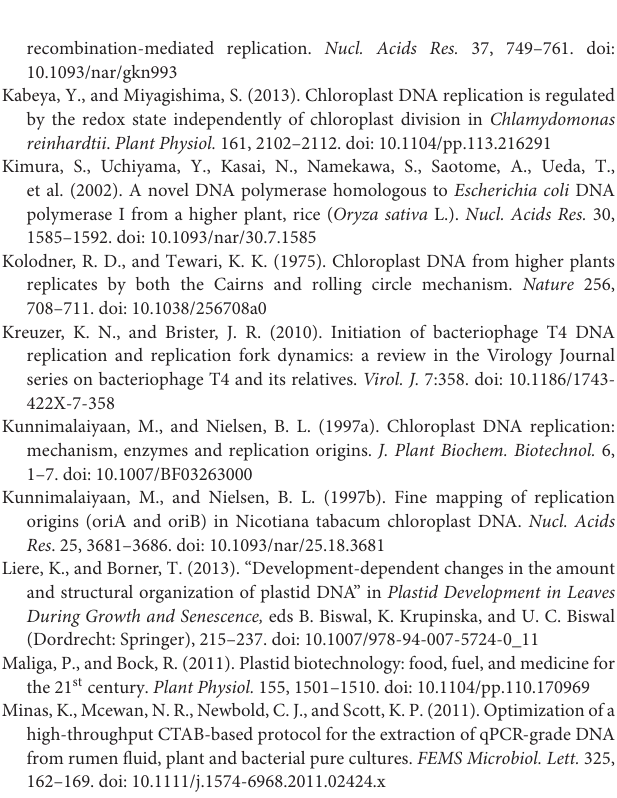
Supplementary Table 2 | Primers used for RT-PCR analysis of PolIA and PolIB expression. Supplementary Table 3 | Primers used for zygosity